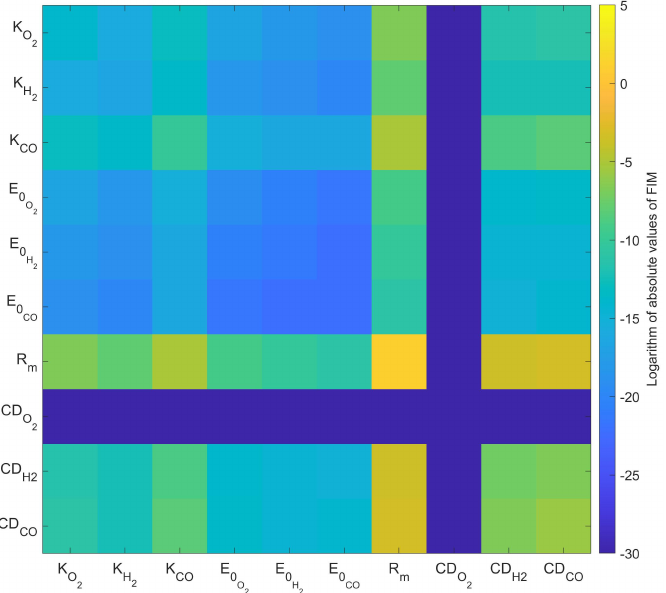
Figure 3. The logarithm of the absolute values of the FIM obtained for the model calibrated on the full experimental data set with the reduced set of calibration